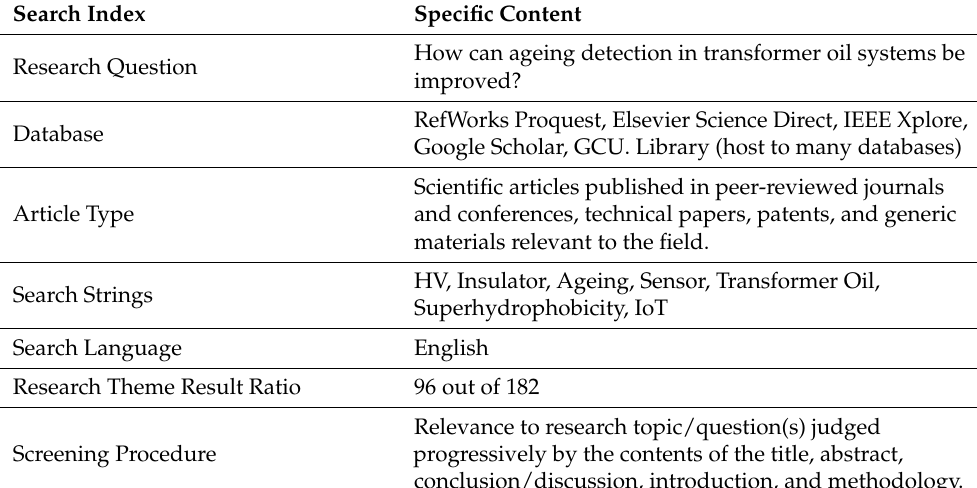
Table 2. Paper Screening